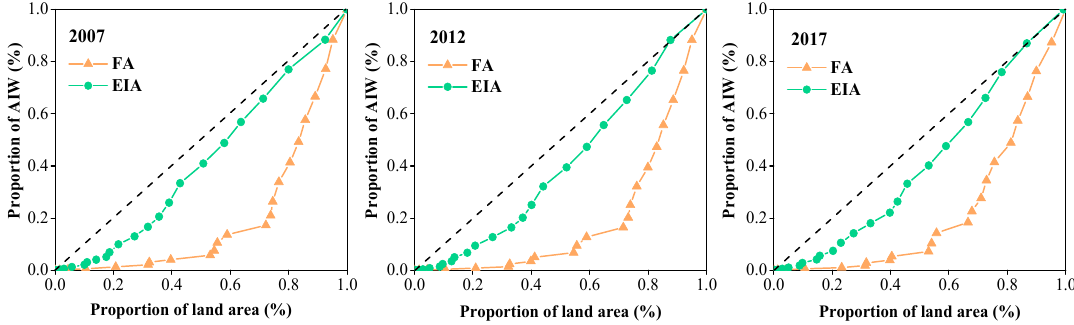
Figure 4. Lorentz curves of agricultural water and land resource matching in Ningxia.